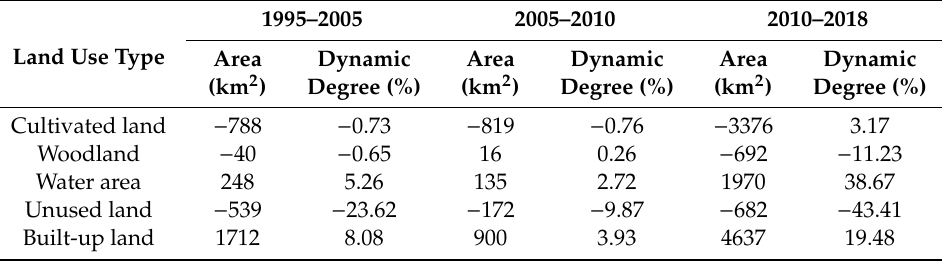
Table 2. Changes in land use area and single dynamic degree in the lower Yellow River area from 1995 to 2018.